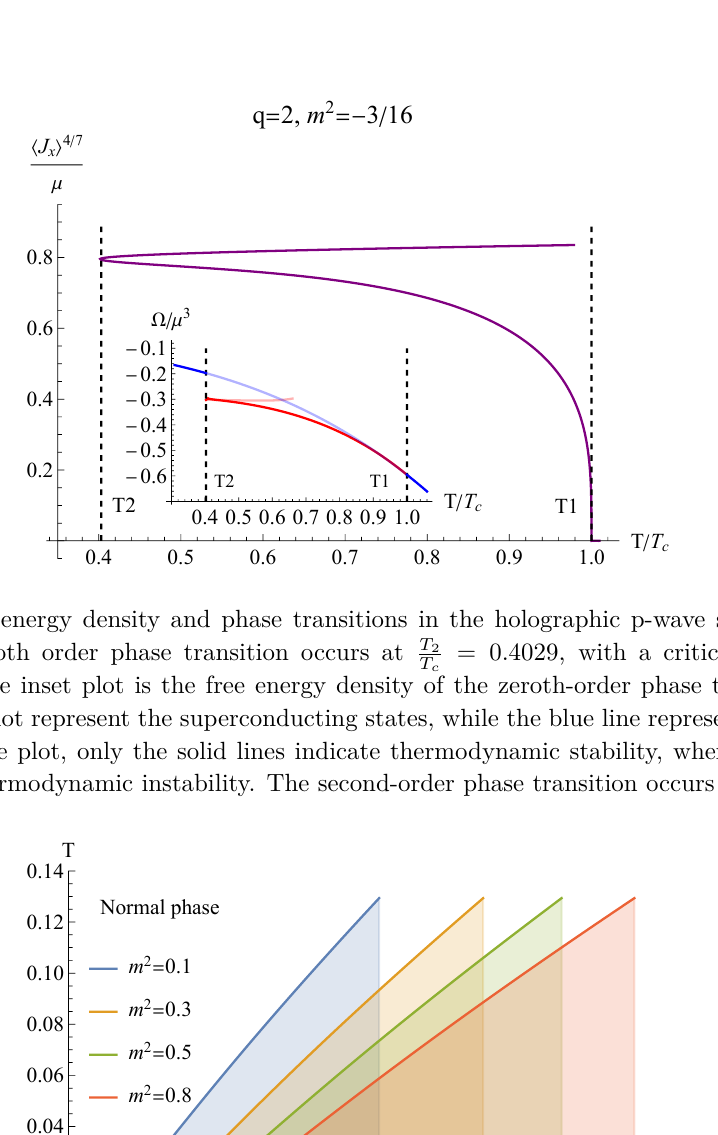
m 2 = 0.1 m 2 = 0.3